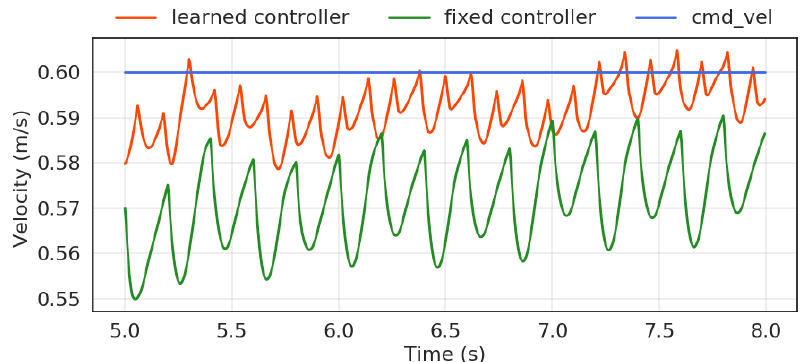
Figure 8. Forward velocity tracking performance.